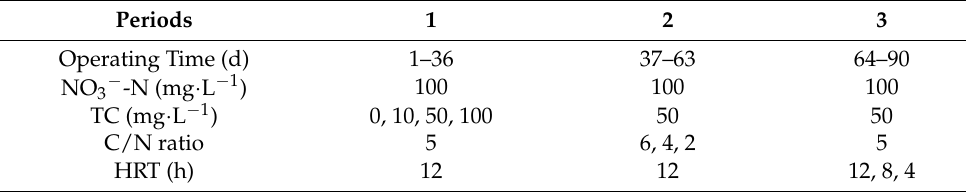
Table 1. Operating procedure of I-BF